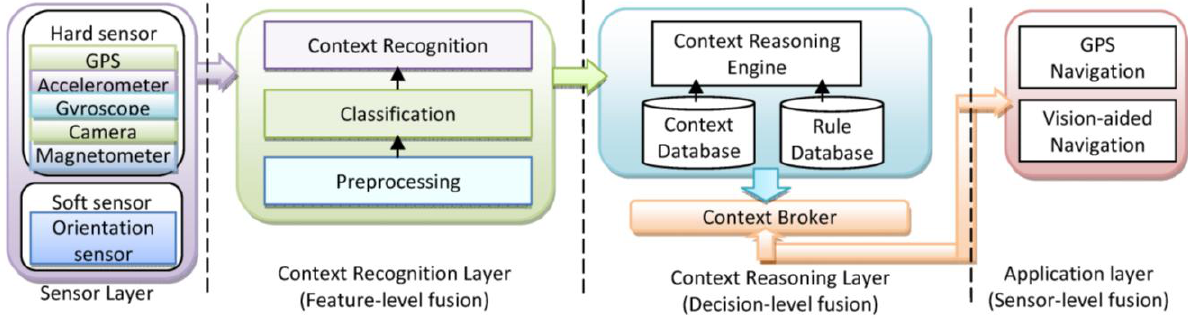
Figure 2. Schematic diagram of the context-aware navigation services